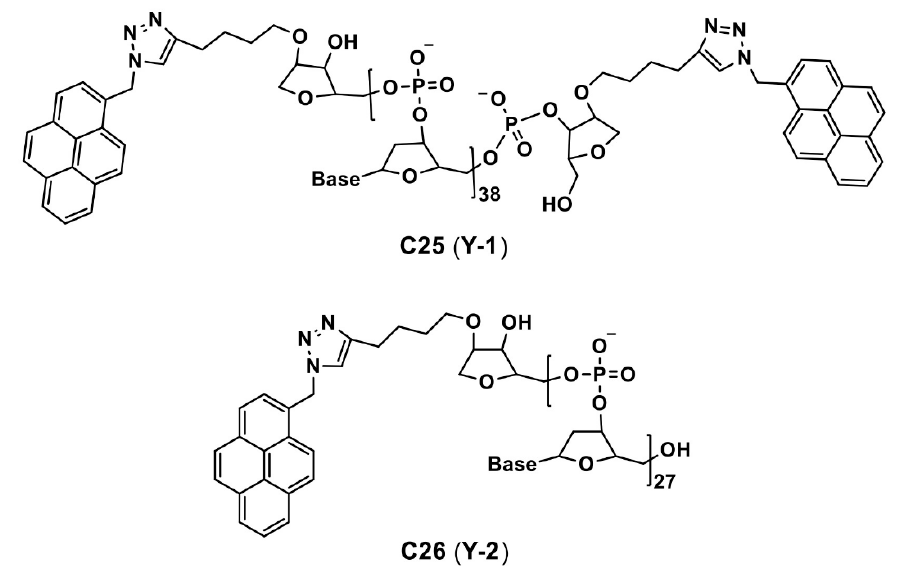
Figure 14. C25 and C26 are the structures of Y-shaped pyrene containing DNA nanoprobe reported for microRNA imaging (Note: the original representation or numbering of the molecules were provided in the brackets along with respective reference number).